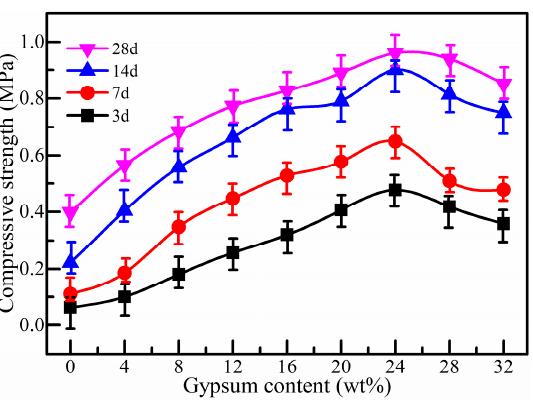
Figure 14. Strength development of hardened SSB-CPB with di ff erent DG dosages and curing